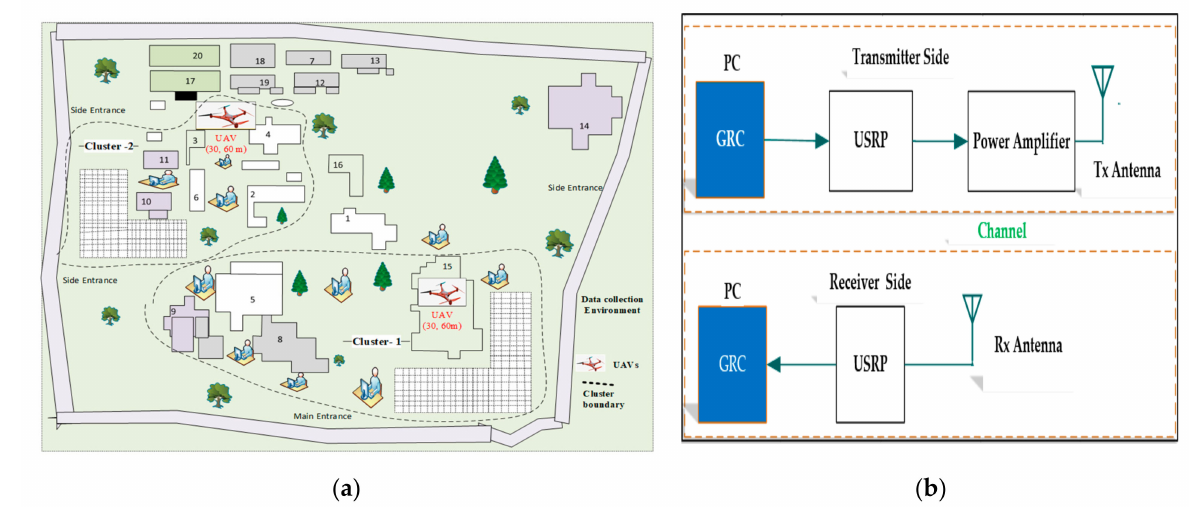
Figure 3. ( a ) Actual NTUT data collection layout. ( b ) Architecture of orthogonal frequency-division multiplexing (OFDM) signal collection strategy from UAV-base stations